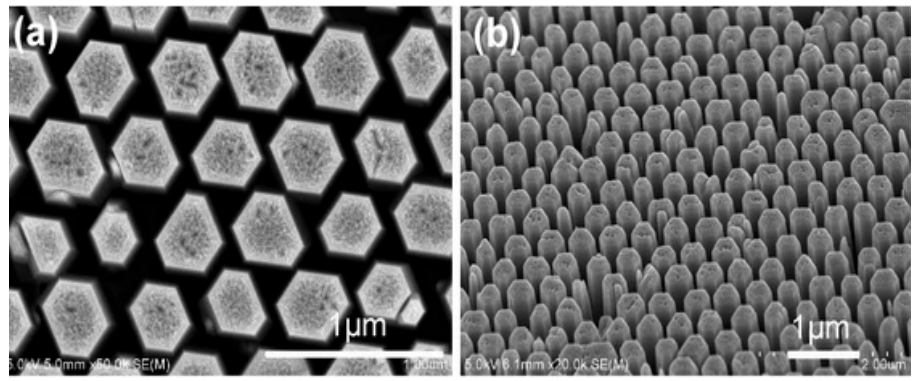
Figure 16. SEM images showing ( a ) top view and ( b ) 45° tilt view of ZnO nanorod arrays. Reproduced from [230] under the terms of the Creative Commons Attribution 4.0 International License.